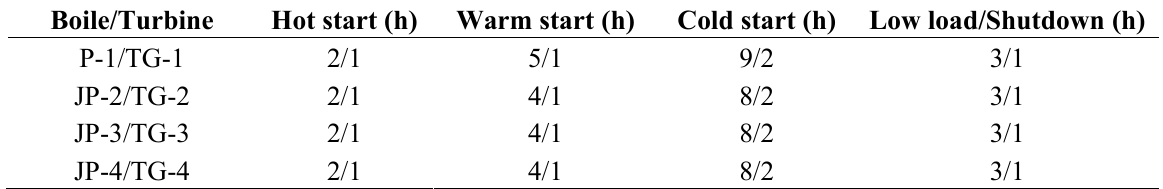
Table 6. Minimum up- and down-time constraints of the boiler/steam turbine